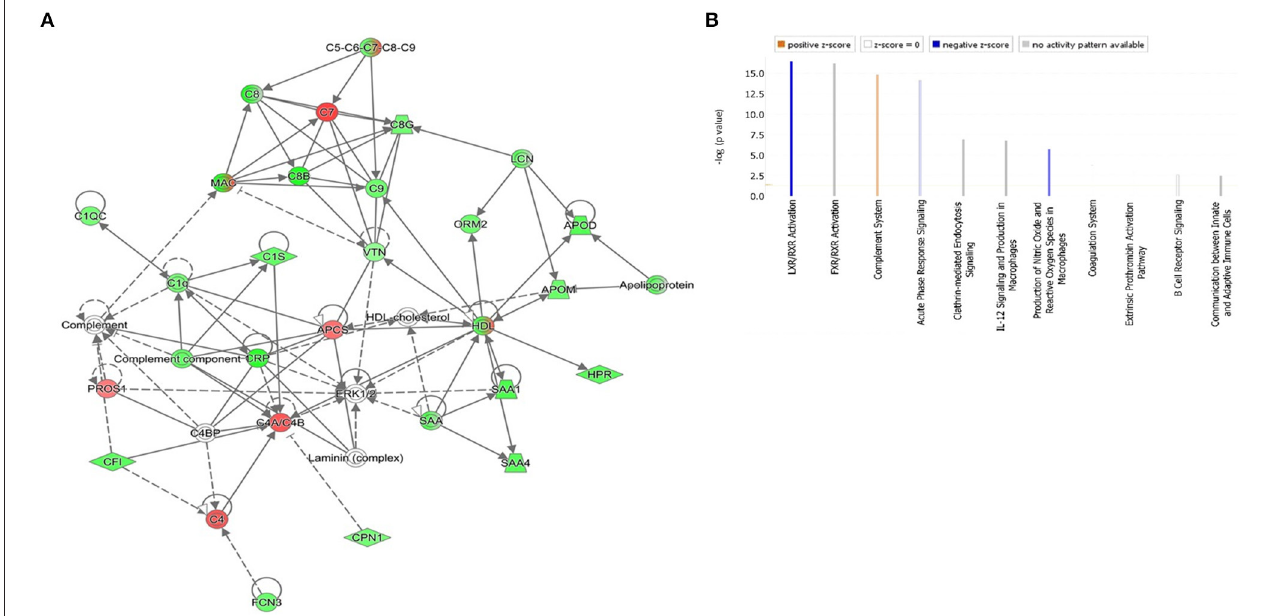
FIGURE 5 | (A) The highest-scoring network pathways depict the involvement of the differentially regulated proteins between patients with the highest score of DOCK8 deficiency vs. AD related to the developmental disorder, hereditary disorder, and infectious disease. Nodes in green and red correspond to downregulated and upregulated proteins, respectively. Colorless nodes were proposed by IPA and suggest potential targets functionally coordinated with the differentially abundant proteins. Solid lines indicate direct molecular interactions, and dashed lines represent indirect interactions. (B) The significantly enriched top canonical pathways determined by IPA core analysis between DOCK8 deficiency and AD. Activated pathways are colored orange ( Z > 0), and inhibited pathways are colored blue ( Z < 0). NA designates pathways without a predicted activity score, which are